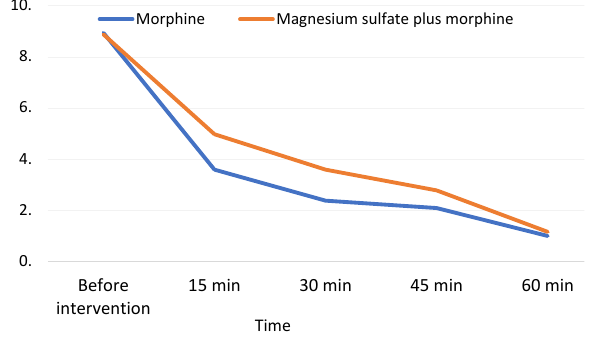
Figure 2 . Pain score trend during the study follow-up.